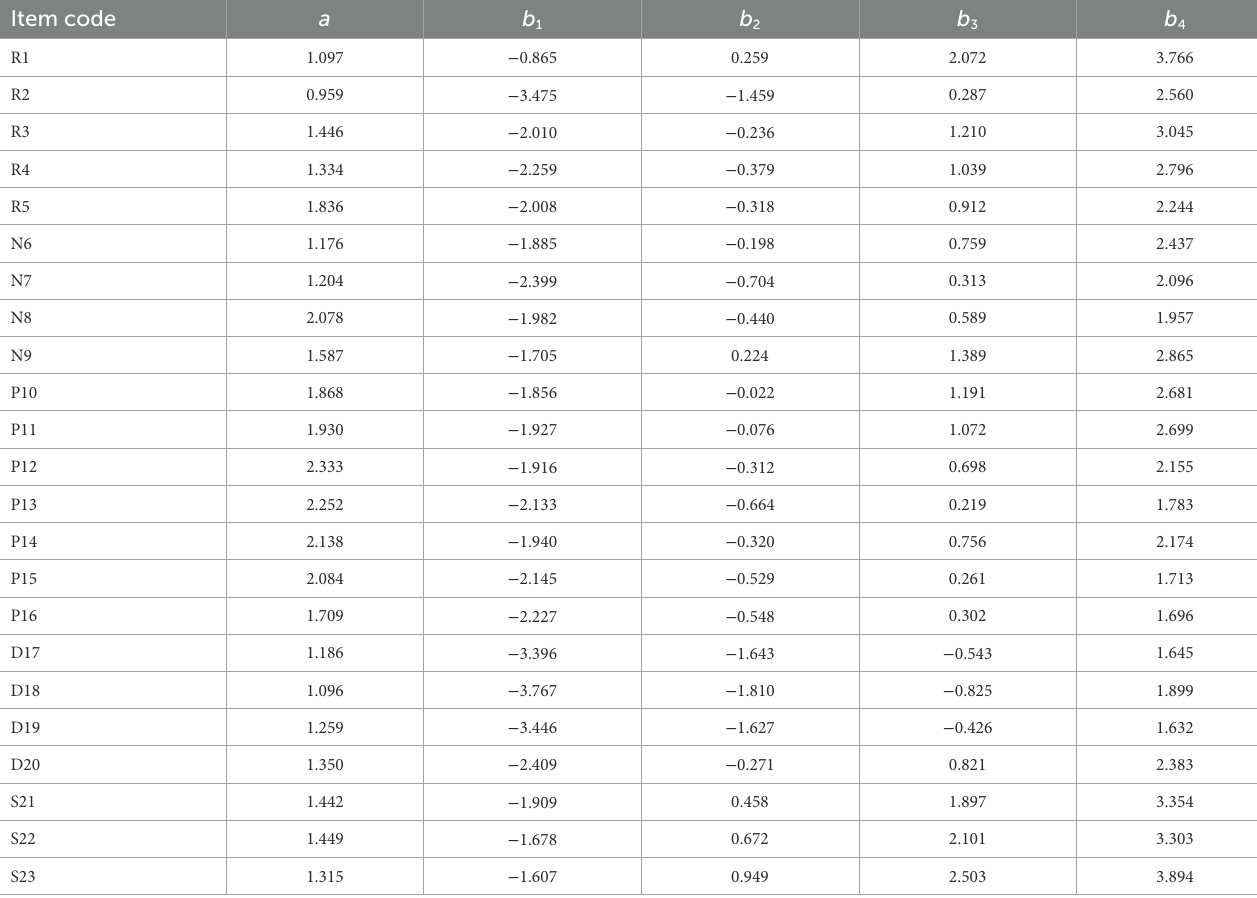
TABLE 5 Estimated item response theory (IRT) parameters of hepatitis B virus infection-related stigma scale (HBVISS) ( n = 1,058). Item